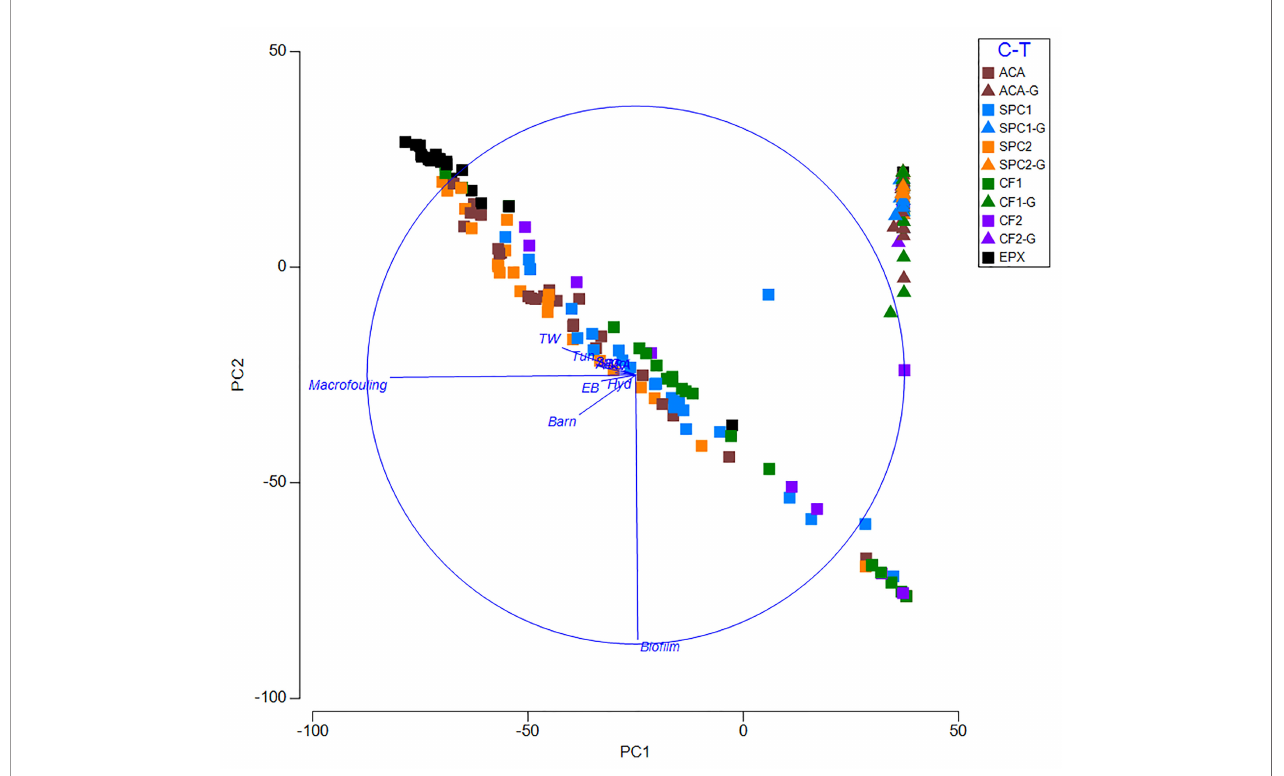
FIGURE 4 | PCA comparing the fouling communities on groomed (triangles) and ungroomed (squares)